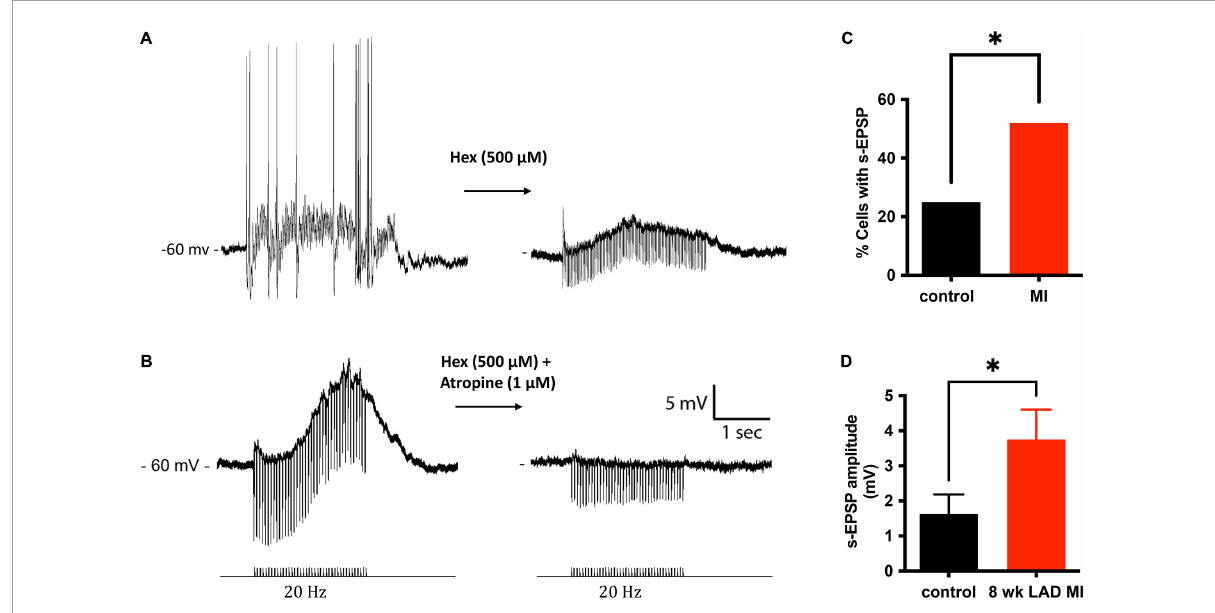
FIGURE5 Muscarinic slow potentials are more prevalent and of greater amplitude after MI. (A) Representative tracings of a slow-EPSPs evoked from one cell before and after administration of hexamethonium (Hex). Hex blocked fast-synaptic potentials elicited by acetylcholine activation of ganglion nicotinic receptors. In the presence of Hex, the slow-EPSP could be elicited reproducibly, as long as the interval between trains was greater than 200 ms. (B) In a separate cell, in the presence of Hex, 20 Hz stimulation of an interganglionic nerve bundle caused a slow depolarization ( ∼ 13 mV) of the postsynaptic membrane. The slow depolarization was inhibited by application of the muscarinic receptor inhibitor atropine. (C) A significantly greater fraction of MI ICNs responded with muscarinic s-EPSPs. (D) In addition to being observed more frequently, the amplitudes of the s-EPSPs were greater in MI ICNs.